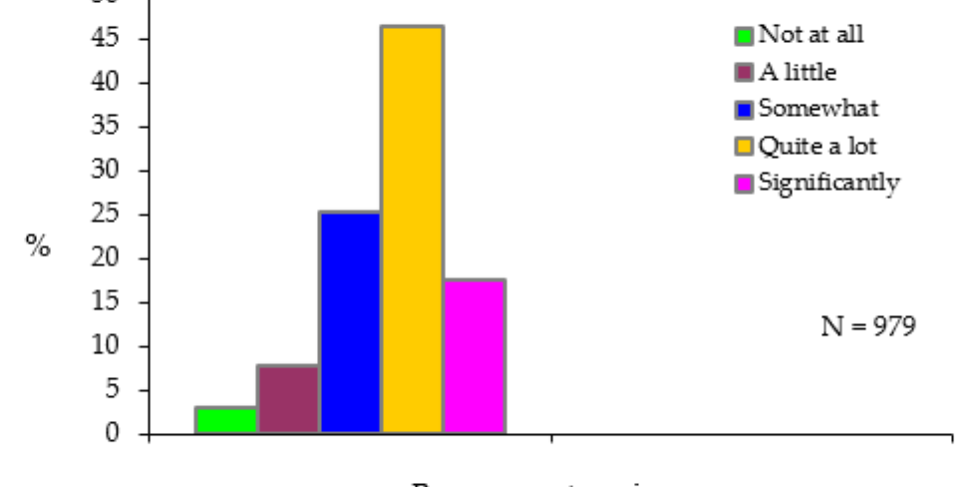
Figure 6. ‘Optimisic you feel’ frequencies.